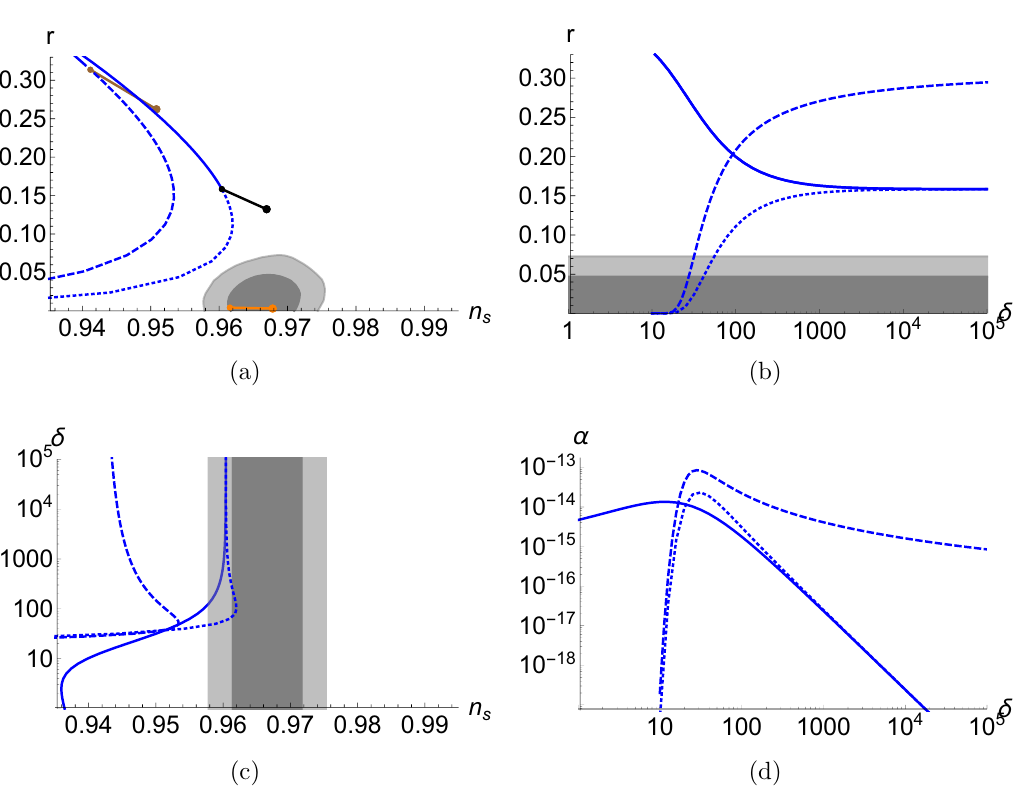
Figure 2. r vs. n s (a), r vs. δ (b), δ vs. n s (c), and α vs. δ (d) with N e = 50 e -folds for the CW potential (2.10). Blue dashed line represents inflation in region 1), blue dotted line in region 2) and blue continuous in region 3). For reference we plot the lines for quartic (brown), quadratic (black) and R 2 (orange) inflation for N e ∈ [50 , 60] . The gray areas represent the 1,2 σ allowed regions from Planck 2018 data [6].